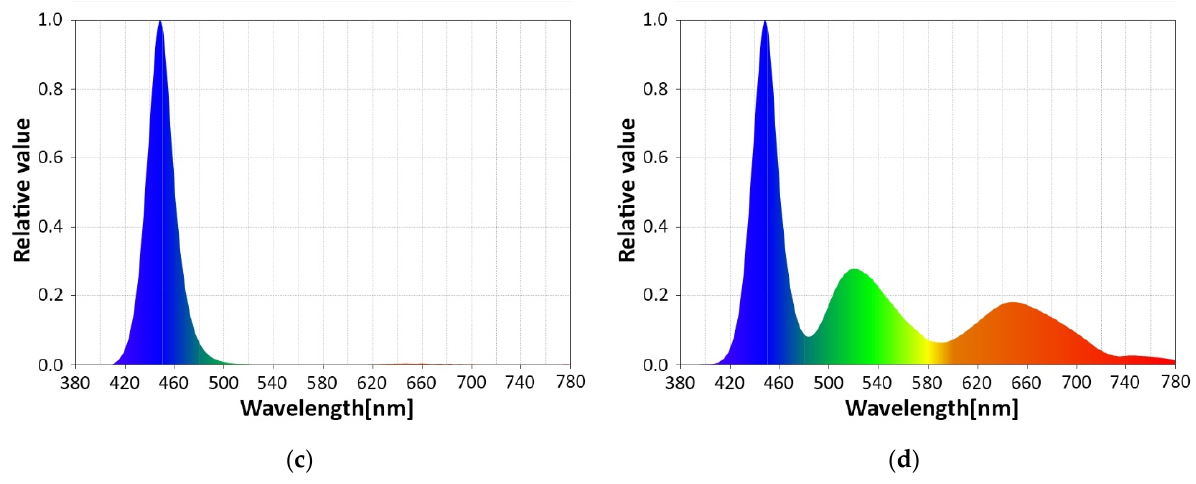
Figure 8. Spectral analyses of: ( a ) VLC emitter red light; ( b ) VLC emitter green light; ( c ) VLC emitter blue light; ( d ) VLC emitter white light.